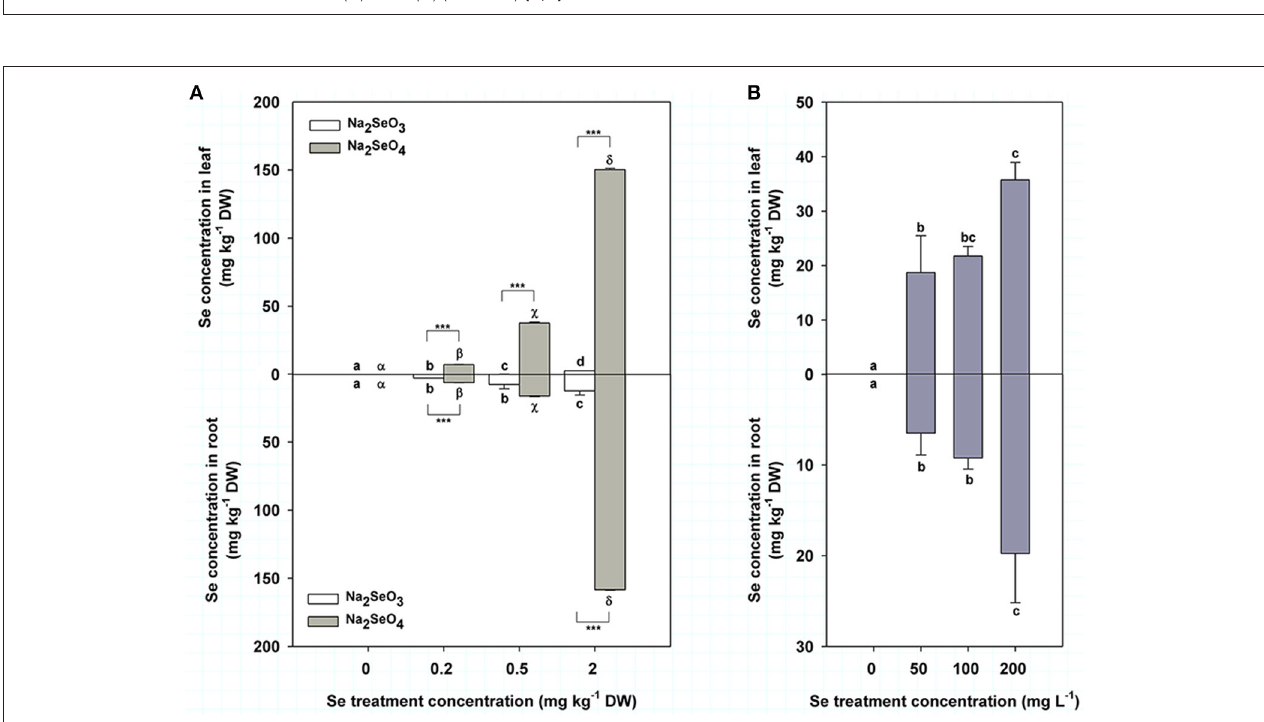
FIGURE 2 | Se concentrations (mg kg − 1 DW) in turnip plants in different Se treatment modes. (A) Se concentrations in turnip leaves (top) and roots (bottom) treated with different concentrations of Se (IV) or Se (VI) by soil addition. (B) Se concentrations in turnip leaves (top) and roots (bottom) treated with different concentrations of Se (IV) by foliar application. Data represent means ± SE ( n = 3). Bars labeled with different letters (a–d or α - δ ) are significantly different among different Se concentrations of Se (IV) or Se (VI) ( P < 0.05) (A,B) . ***Represents a significant difference between two treatments ( P < 0.001) (A) .